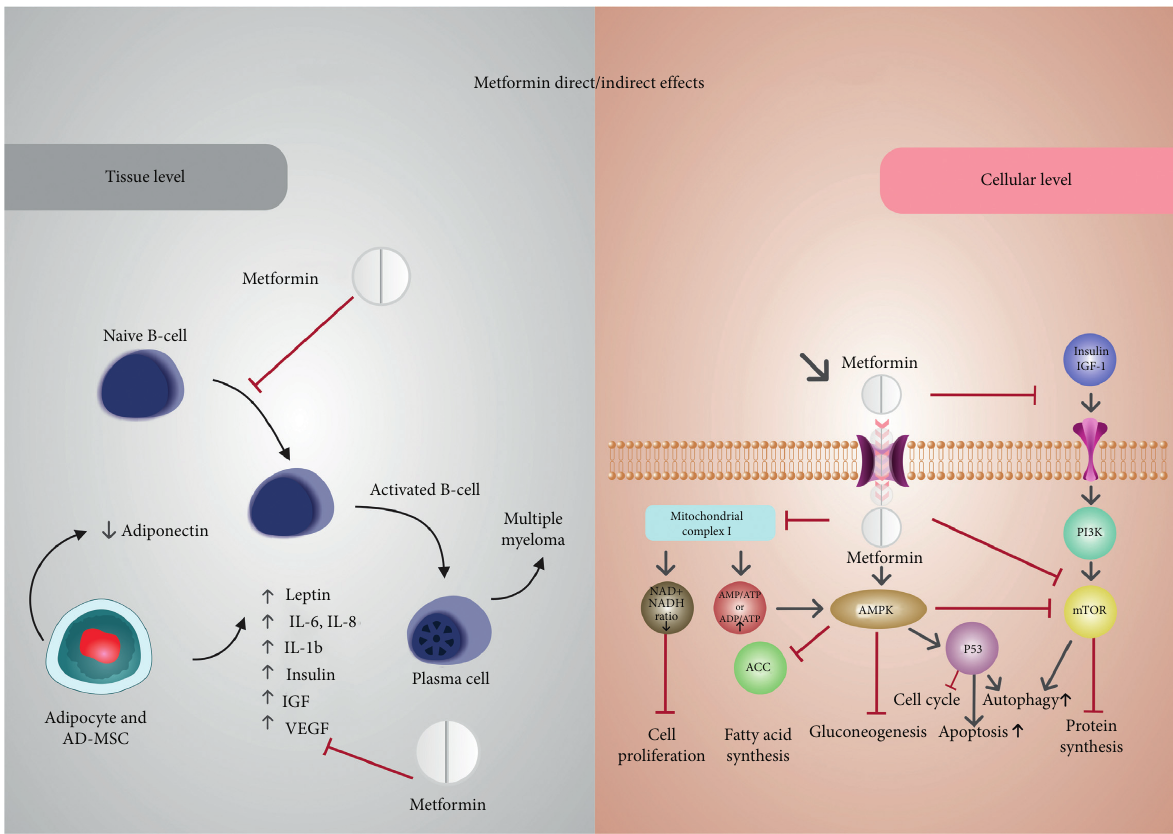
Figure 1: Figure modified from [32]. Overview of cellular and tissue mechanisms of metformin on inhibiting plasm cell growth. Metformin inhibits at tissue level: the inflammation caused by increases in circulating levels of leptin, insulin, IGF, IL-6, IL-1, and VGFR, driving by adipocyte differentiation of bone marrow mesenchymal stromal cells (AD-MSCs); and a cellular level inhibits mitochondria complex I, stimulates the adenosine monophosphate-activated protein kinase (AMPK) signaling pathway, and/or inhibits the insulin signaling pathway. ACC, acetyl-CoA carboxylase; EMT, epithelial-mesenchymal transition; IGF, insulin growth factor; IGF-1, insulin-like growth factor-1; IGF-1R, insulin-like growth factor-1 receptor; IR, insulin receptor; IL-1, interleukin 1; IL-6, interleukin-6, OCT1, organic cation transporter 1; VGFR, endothelial growth